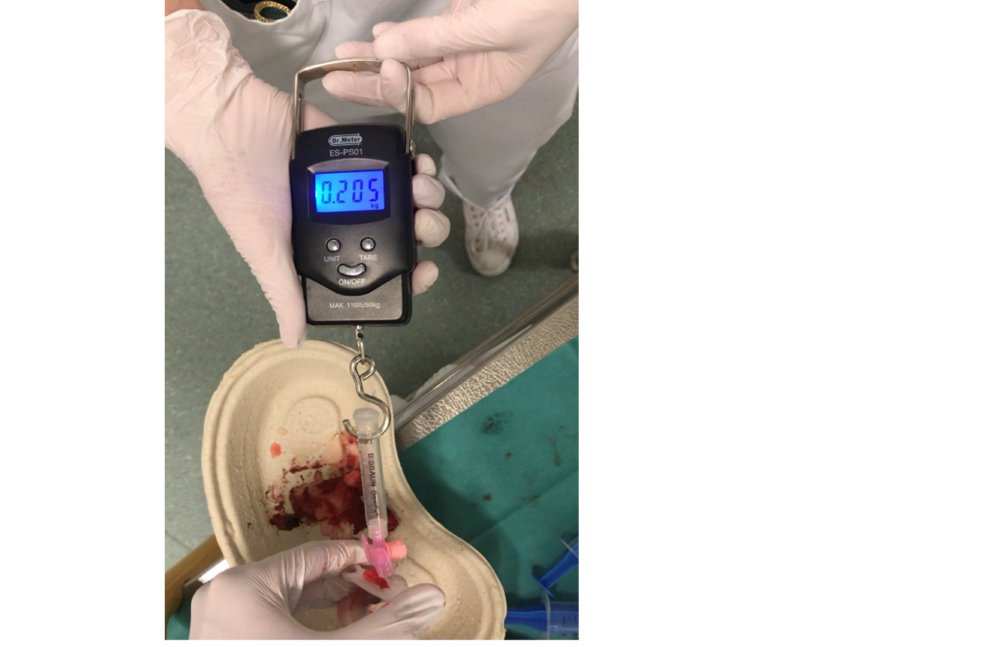
Figure 4. An electronic spring scale was connected to a prepared disposable syringe and to the catheter via a Luer lock connection. By slowly pulling the disposable umbilical clamp, the force to release the securement was